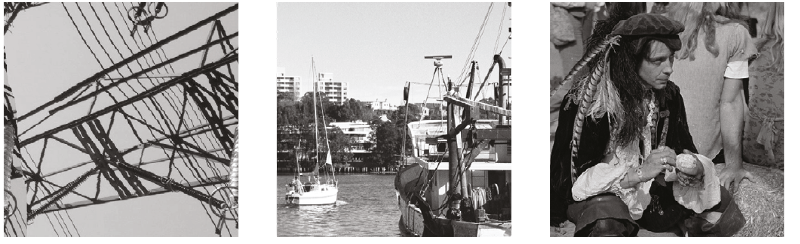
Figure 9: Image files in the training data set (Fold